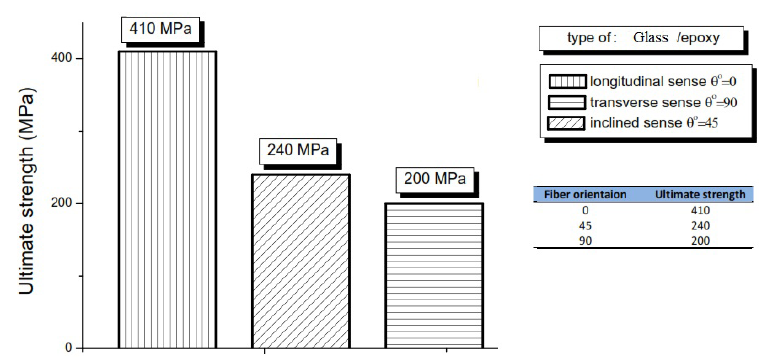
Figure 6. Ultimate strength depending on the fibers orientation of glass/epoxy.